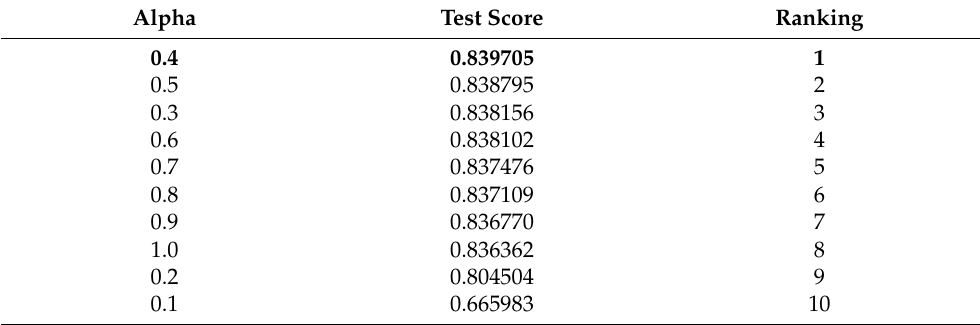
Table 7. Using the GridSearchCV , the model with the top 10 alpha parameters yields the following accuracy scores and are ranked accordingly. Alpha Test Score Ranking 0.4 0.839705